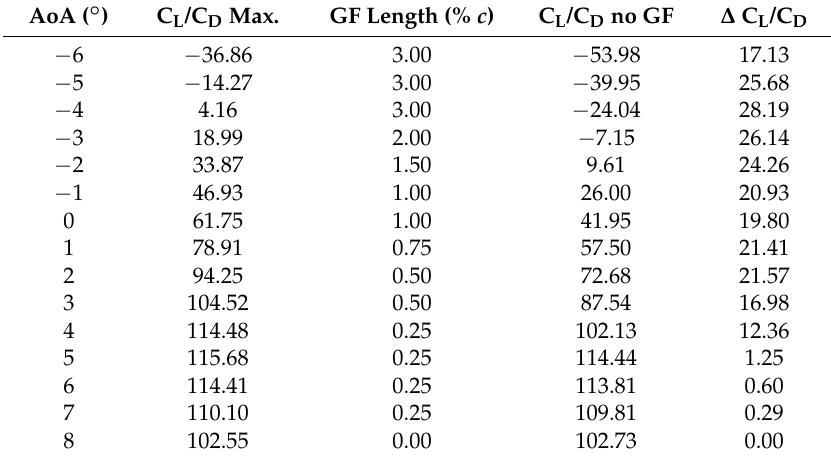
Table 3. Optimum GF length for each angle of attack studied and the increment in lift-to-drag ratio with respect to the case with no GF implementation.